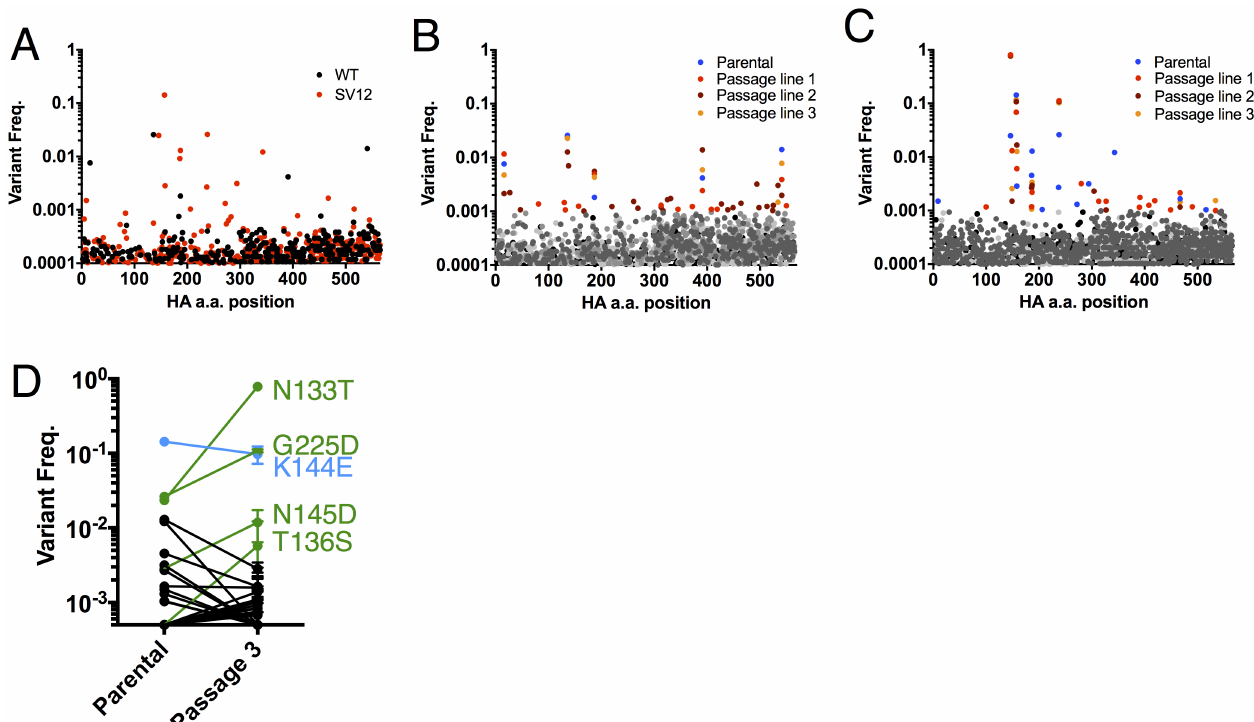
Fig 5. PrimerID sequencing of HA genes from recombinant WT and SV12-HA following passage. Recombinant PR8 (WT) and rSV12-HA (SV12) viruses were rescued via reverse genetics. (A) Amino acid variant frequencies within WT (black) and SV12 HA (red) populations collected from rescue supernatants without amplification, as determined by primerID sequencing. ( B,C ) Amino acid variant frequencies within WT (B) and rSV12-HA (C) populations following three passages in eggs. For each population, all variants over 0.1% are colored to allow them to be visually distinguished. (D) Comparison of amino acid variant frequencies within rSV12-HA populations before and after 3 passages in eggs. Passage 3 data represents mean +/- SD of three independent passage lines. All amino acid numbering indicated on graphs A-C is from initiating methionine, not according to H3 system.